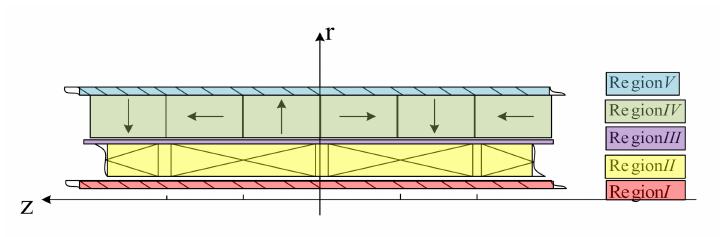
Figure 2. Structure of moving-coil tubular permanent magnet linear motor